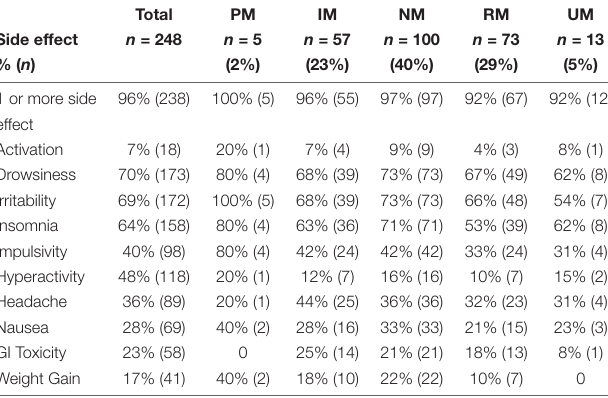
TABLE 3 | Frequency of side effects in tolerability